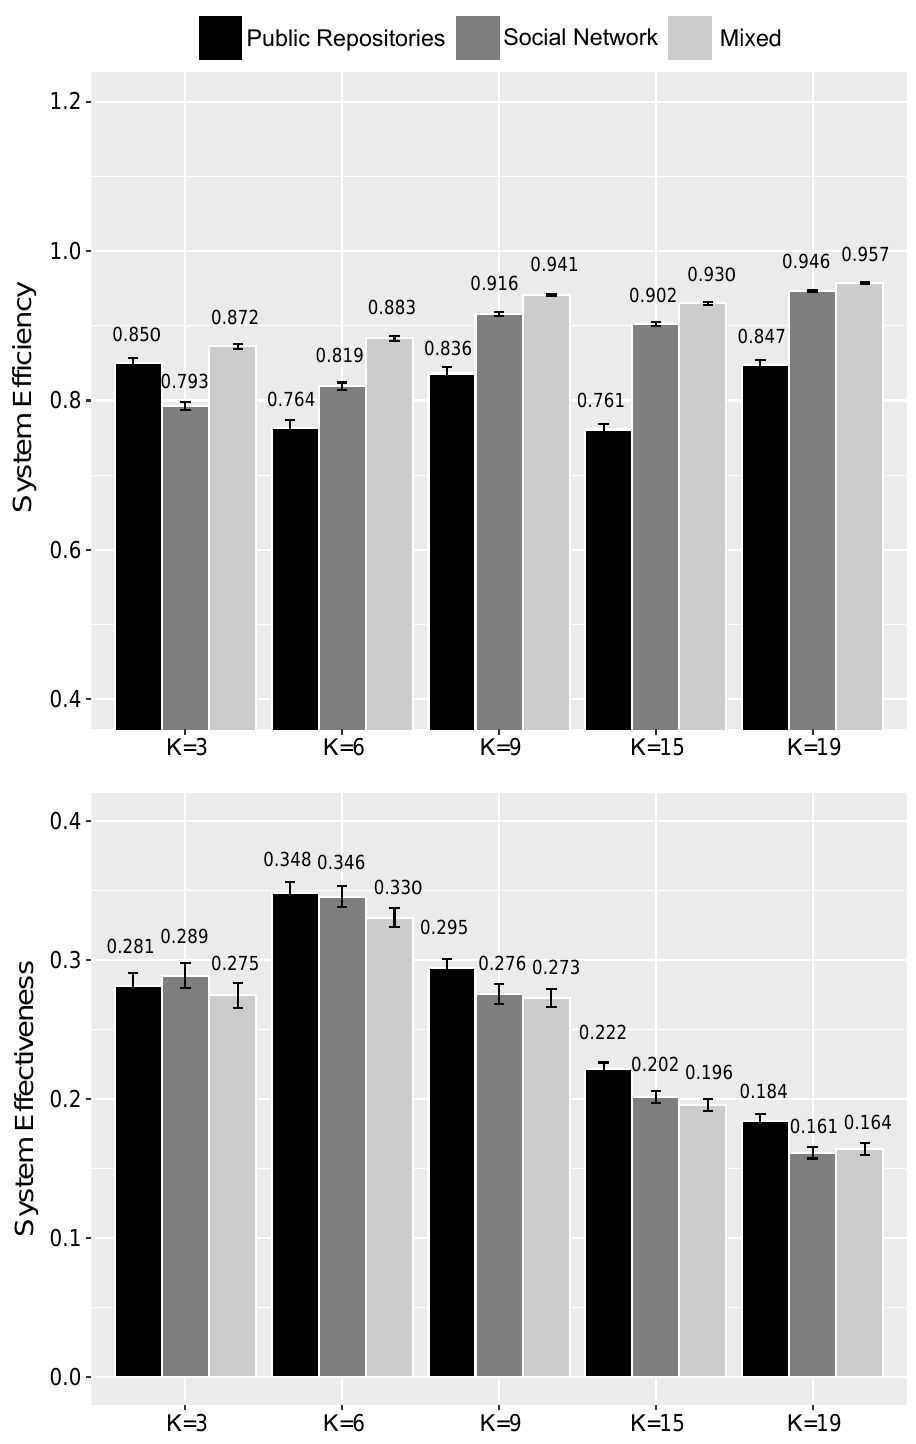
Figure 7: Effects of public repositories, social network, and mixed information on system efficiency and effectiveness (with a varied problem complexity K in the NK model) in the knowledge transformation models. The maximum efficiency and effectiveness in both models are normalized to 1. sociological science |